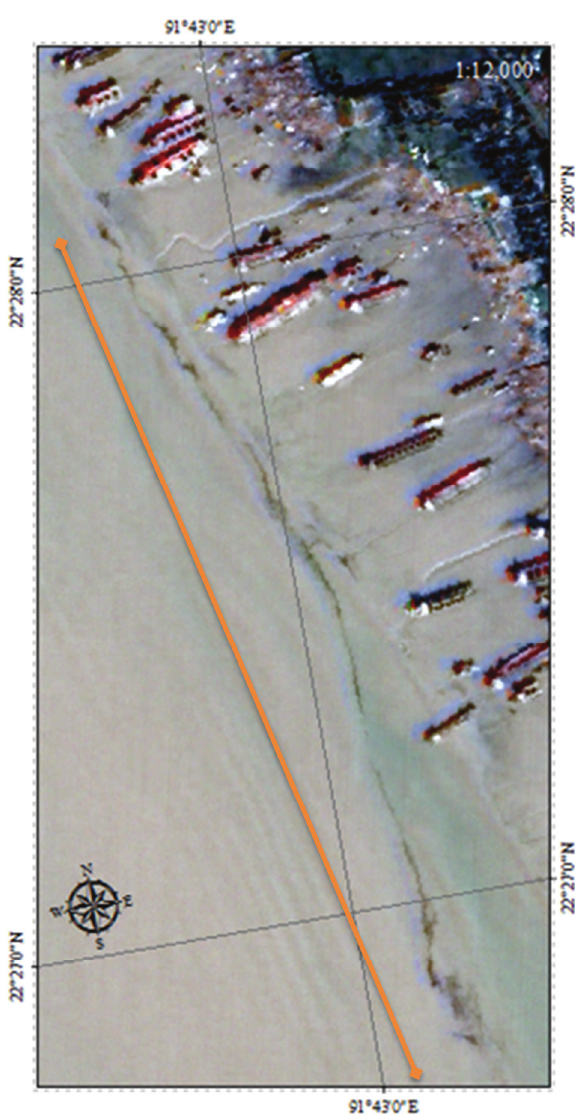
Figure 7. ALOS imagery capturing oil spill from breaking vessel at 1:5,000 scale on November 22, 2009 ©PASCO / Included Material ©JAXA